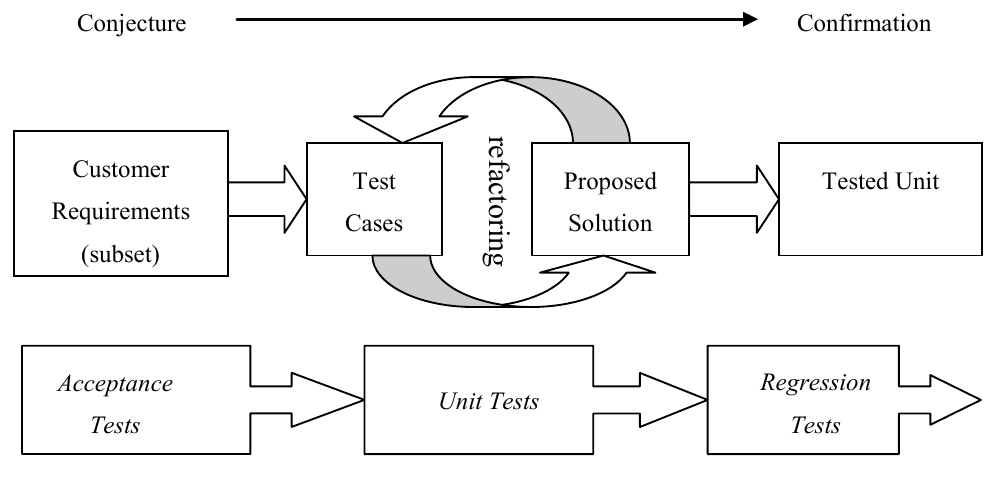
Figure 2. Test driven model of the development of a unit of